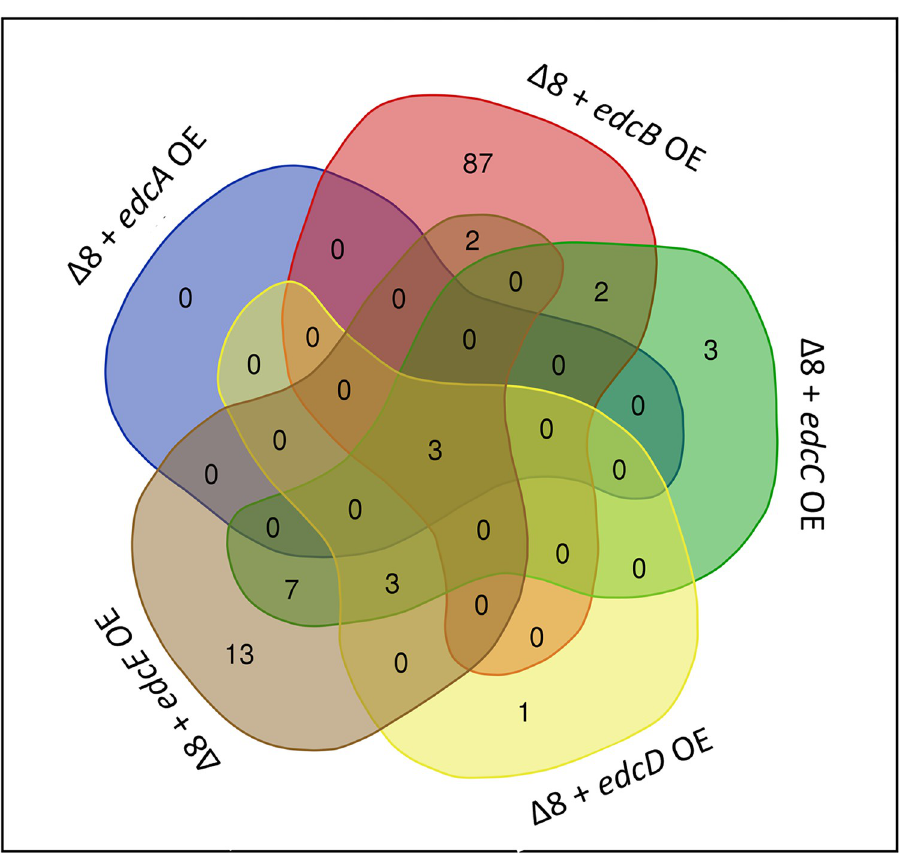
Fig 5. Regulatory divergence among the Edcs. A) A venn diagram representing the distribution of the DEGs in Ea1189 Δ 8 strain overexpressing individual edc genes measured via RNAseq. A total of 121 DEGs both positively and negatively affected in expression were found after being filtered through a DESeq2 FDR cutoff of 0.05 with at least a two fold change (log2) individually for each comparative condition of Ea1189 Δ 8 vs Ea1189 Δ 8 overexpressing an individual edc gene. Ea1189 Δ 8 overexpressing edcB had the highest number of uniquely regulated DEGs. There were three DEGs that were downregulated upon the overexpression of every edc gene in Ea1189 Δ 8. Note that these results also include each of the edc genes themselves in each comparison if filtered through the statistical cutoff requirement. The venn diagram tool software (accessible at bioinformatics.psb.ugent.be/webtools/Venn/) was used to generate the venn diagram using RNAseq data.